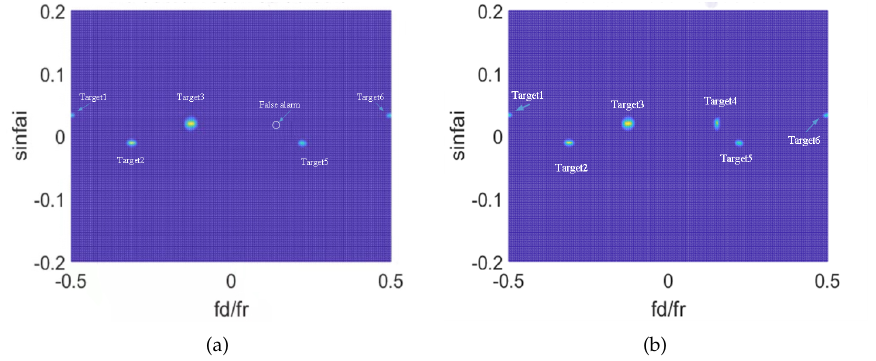
Figure 20. The results after detection, when there are multiple targets: ( a ) traditional method, ( b ) proposed